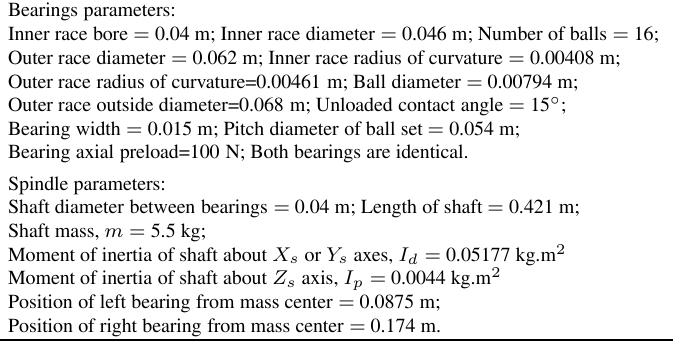
Table 6 Experimental grinding spindle-bearings assembly parameters, [16,51]